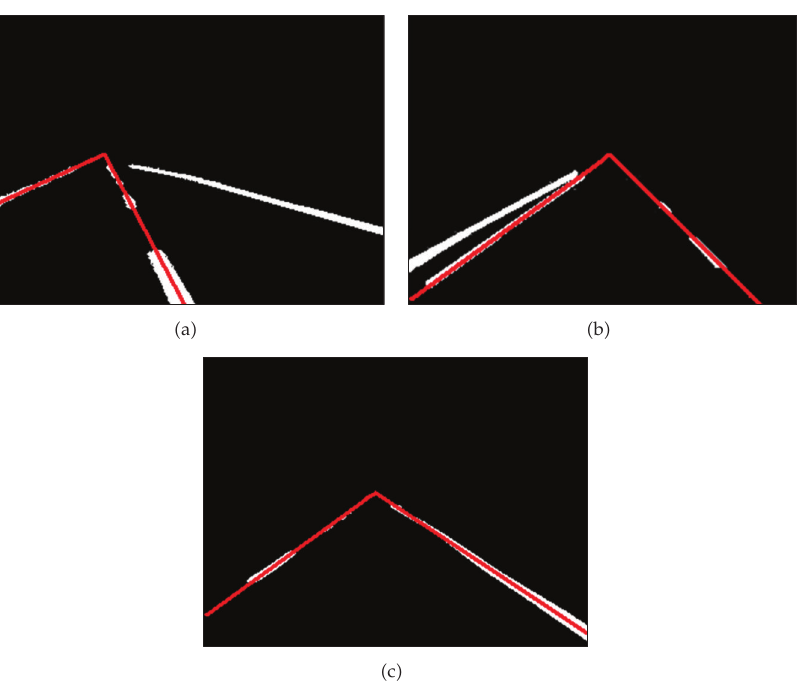
Figure 9: Detection results with angle